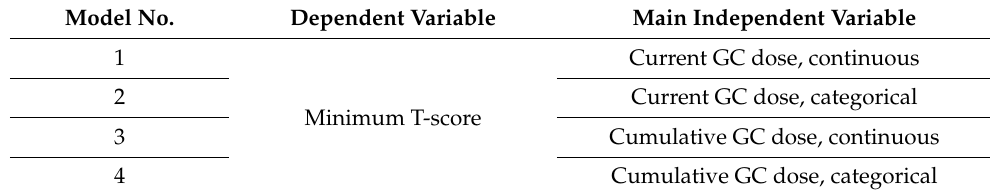
Table 1. Description of main statistical models. Model No. 2 3 Cumulative GC dose, continuous 4 Cumulative GC dose, categorical